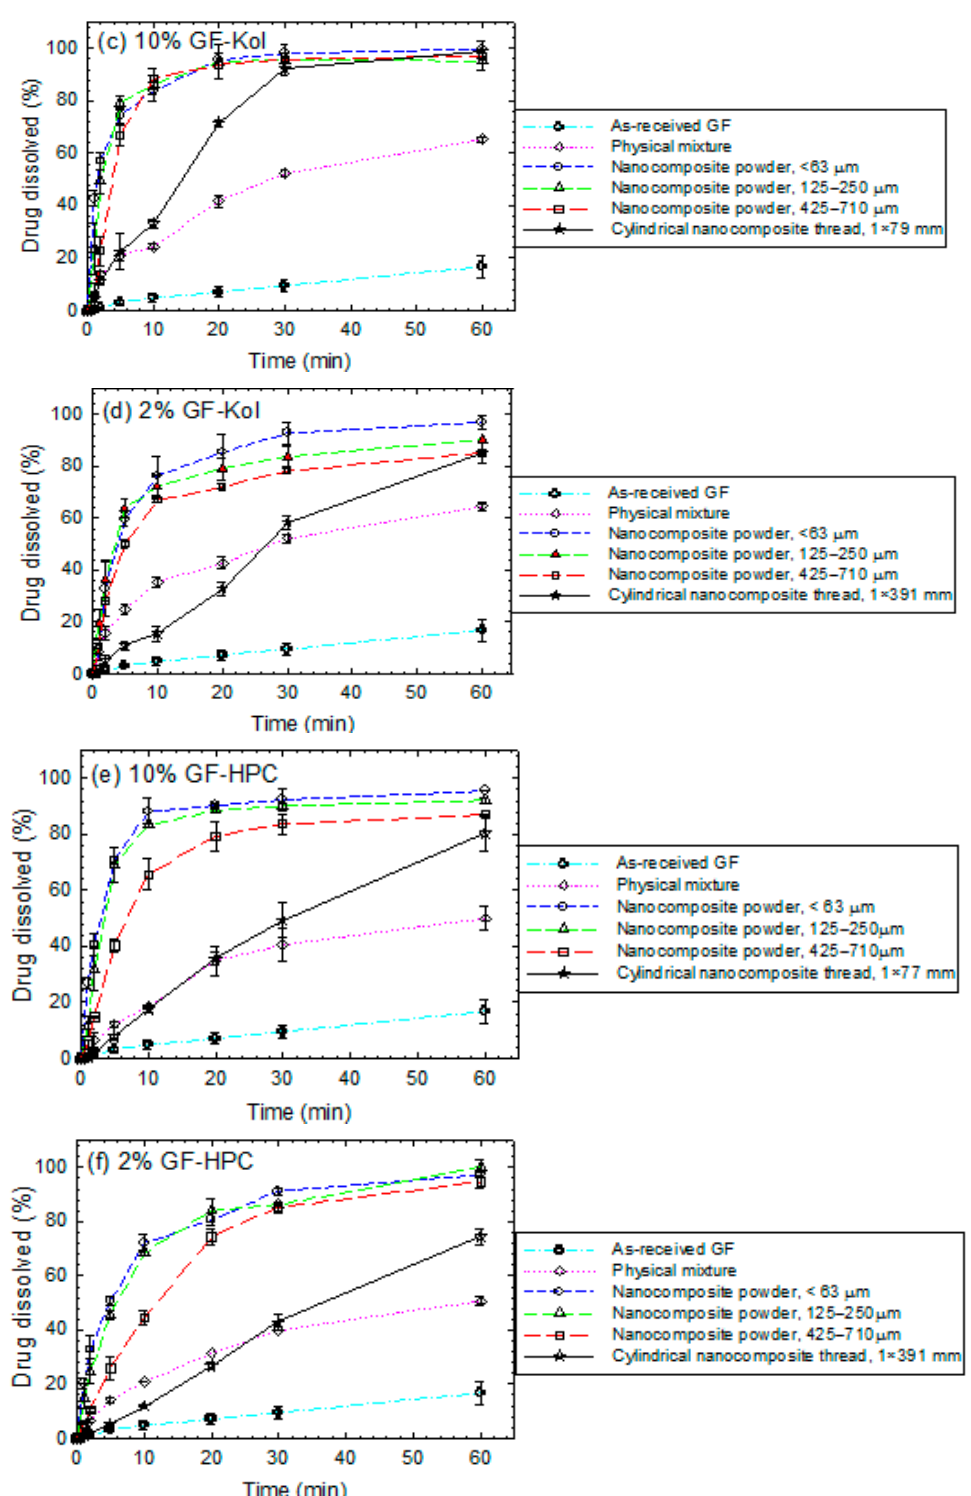
Figure 4. Evolution of GF release during dissolution of as-received GF microparticles, physical mixtures (PMs), thread of the extrudate, and extrudate powders with various formulations–sieved fractions: ( a ) 10% GF-Sol, ( b ) 2% GF-Sol, ( c ) 10% GF-Kol, ( d ) 2% GF-Kol, ( e ) 10% GF-HPC, and ( f ) 2% GF-HPC. The sample size is equivalent to 8.9 mg GF dose (non ‐ supersaturating condition).